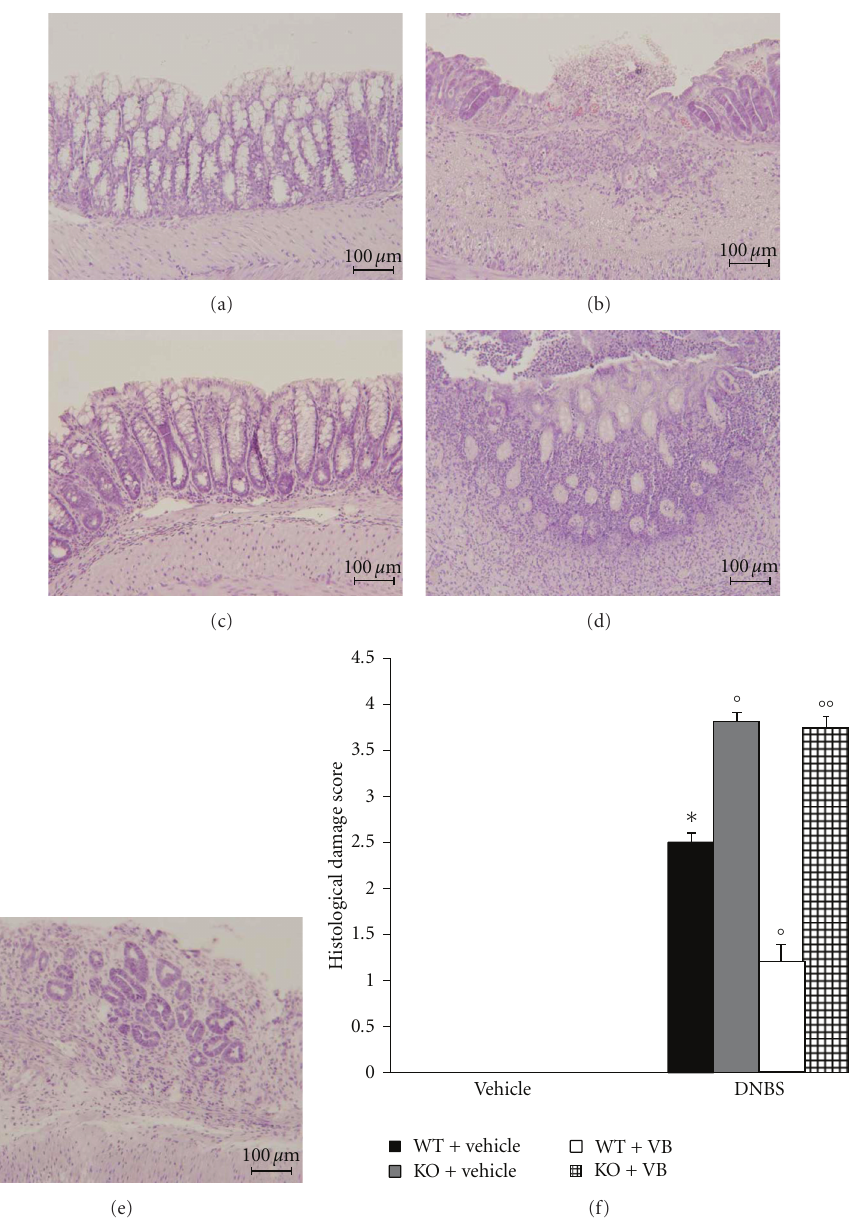
Figure 3: No histological alteration was observed in the colon section from sham-operated mice (a). Mucosal injury was produced after DNBS administration characterized by absence of epithelium and a massive mucosal and submucosal infiltration of inflammatory cells (b). Treatment with VB corrected the disturbances in morphology associated with DNBS administration in PPAR- α WT (c). The absence of PPAR- α gene significantly increases the extent and severity of the histological signs of colon injury (d). The genetic absence of the PPAR- α receptor significantly reduced the e ff ect of the VB treatment (e). The histological score (f) was made by two independent observers. Figure 3 is representative of at least 3 experiments performed on di ff erent experimental days. Data are means ± SEM of 10 mice for each group. ∗ P < . 01 versus Sham; ◦ P < . 05 versus DNBS-WT group.